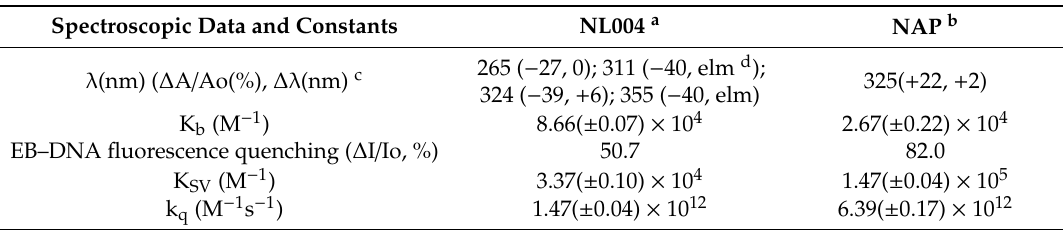
Table 3. Comparison of the spectroscopic data (changes of the UV-band, % of ethidium bromide (EB)– DNA fluorescence quenching), the quenching and the binding constants of NL004 and free NAP for CT DNA (K b ) and competitive studies with EB (Ksv, k q ).